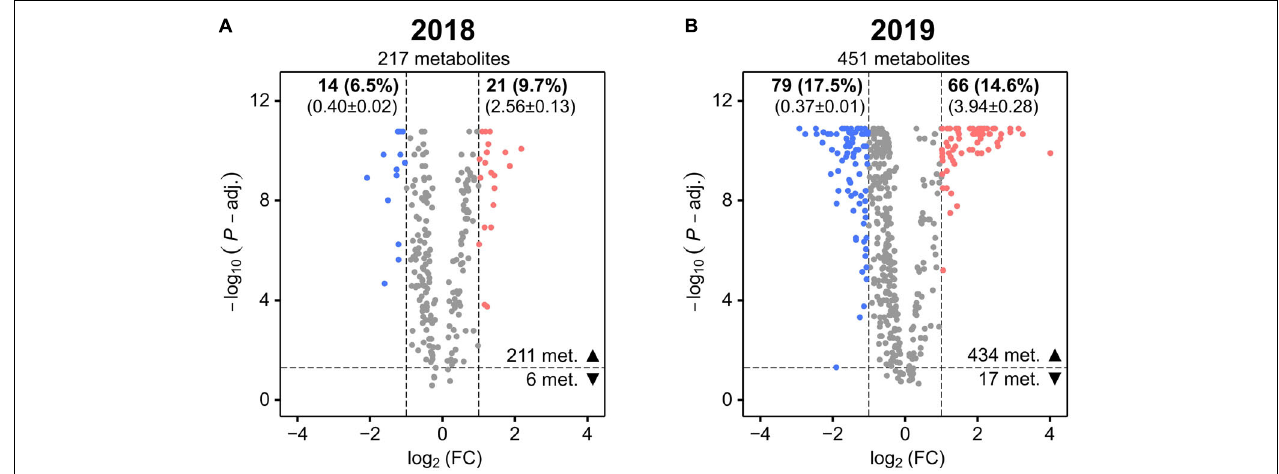
FIGURE 4 | Volcano plots showing the stress-induced significant mean fold changes (FC) of cotton leaf metabolites in 2018 (A) and 2019 (B) . The horizontal dashed line represents the FDR-corrected Mann–Whitney U -test’s P -value of 0.05 ( P -adj.). The vertical dashed lines represent FC < 0.5 or > 2. For each metabolite, the negative log 10 of the P -value is plotted against the log 2 of the mean FC. Metabolites with a significant FC decrease or increase are colored in blue and red, respectively (the other metabolites are colored in gray). The total number of metabolites is reported in each plot (under the year) as well as the number of the ones with P -value < 0.05 ( (cid:78) ) or P -value > 0.05 ( (cid:72) ). The number and percentage (in brackets) of metabolites with P -value < 0.05 and with a significant FC decrease and increase is reported in bold font (at top of the plot) together with their mean FC ± SD (below in